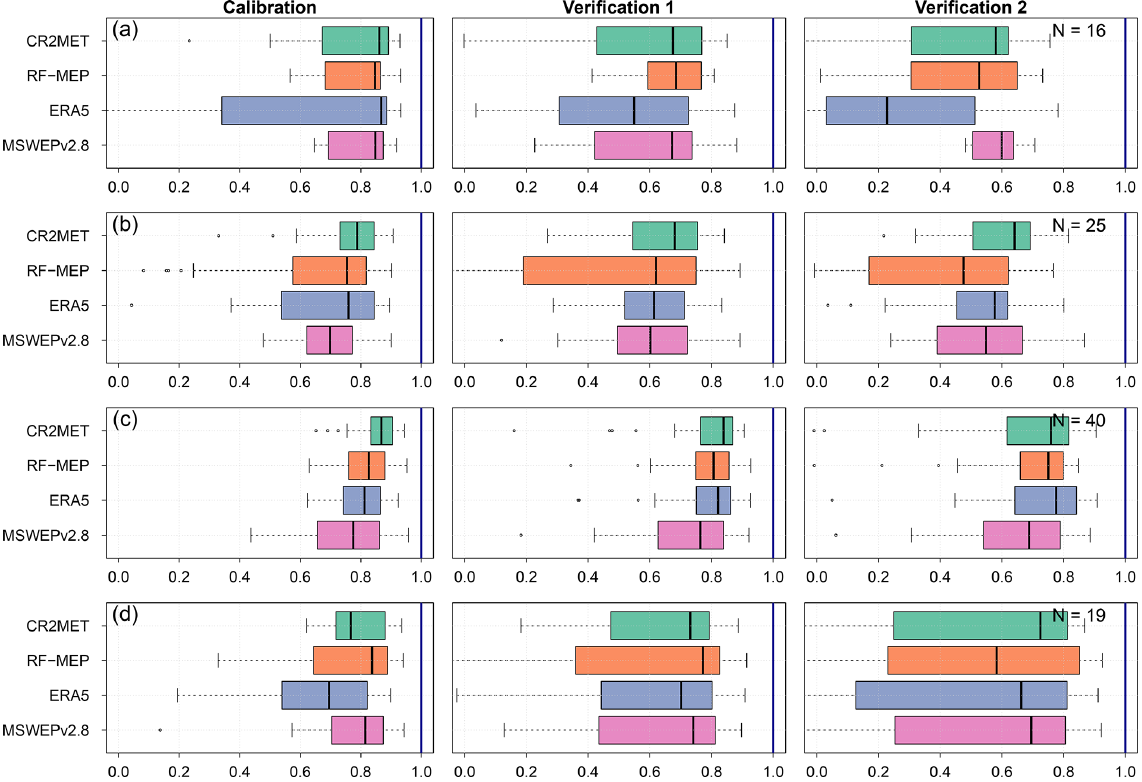
Figure 5. Performance of TUWmodel during calibration (2000–2014), Verification 1 (1990–1999), and Verification 2 (2015–2018), prior to any regionalisation, over catchments with different hydrological regimes: (a) snow-dominated, (b) nivo-pluvial, (c) pluvio-nival, and (d)